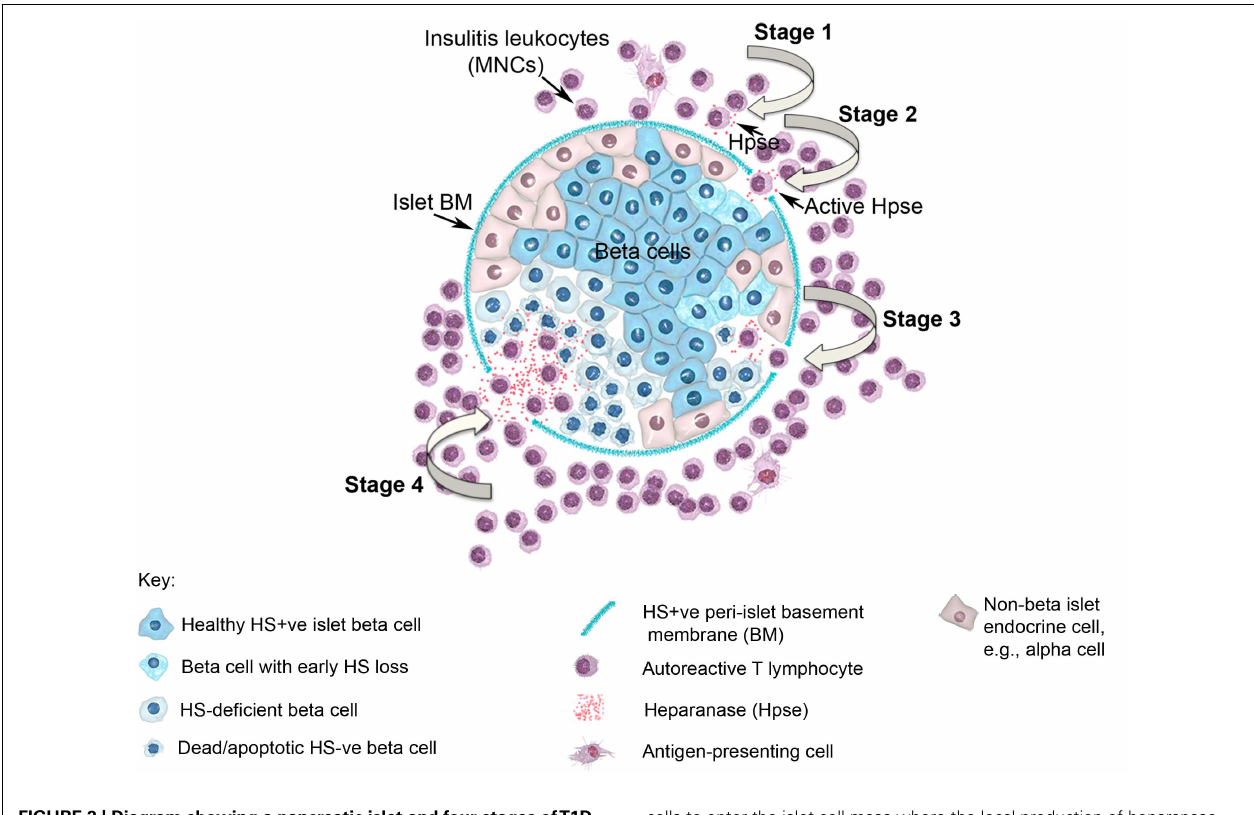
cells to enter the islet cell mass where the local production of heparanase leads to degradation of intracellular HS in islet beta cells (paling blue color; Stage 3). Progression of HS depletion throughout the islet beta cell population results in increased beta cell death (palest blue color in “shriveled” beta cells; Stage 4), loss of insulin production and ultimately the development ofT1D. MNC, mononuclear cell; BM, basement membrane; Hpse,